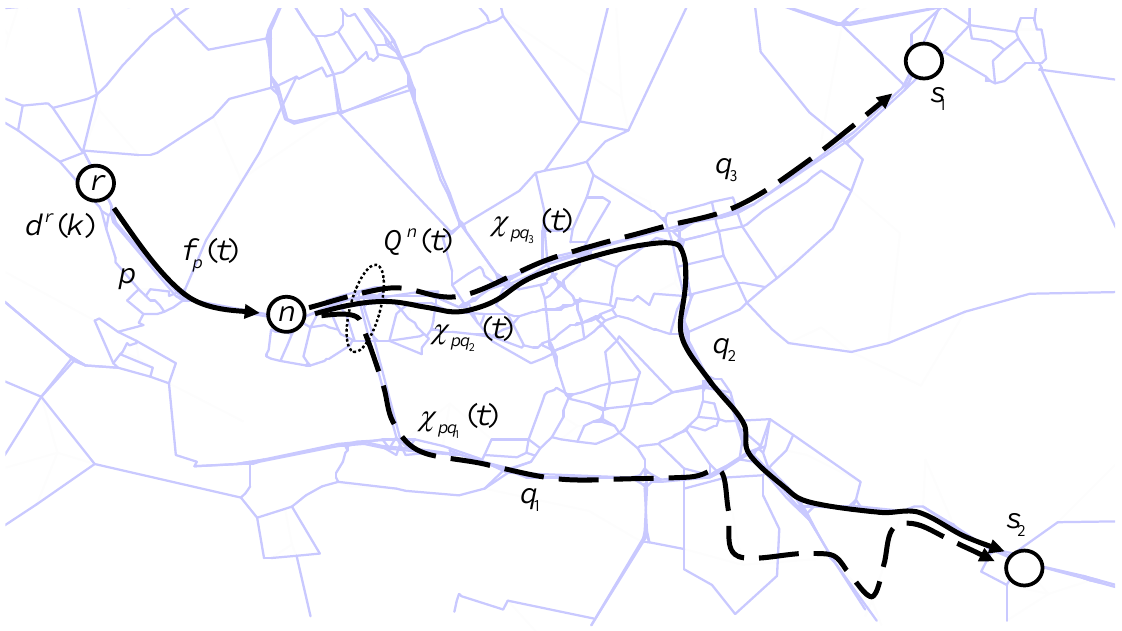
Figure 2. Model variables: Origin r, intersection n, and safe destination s. Dynamic travel demand rate ( ), r